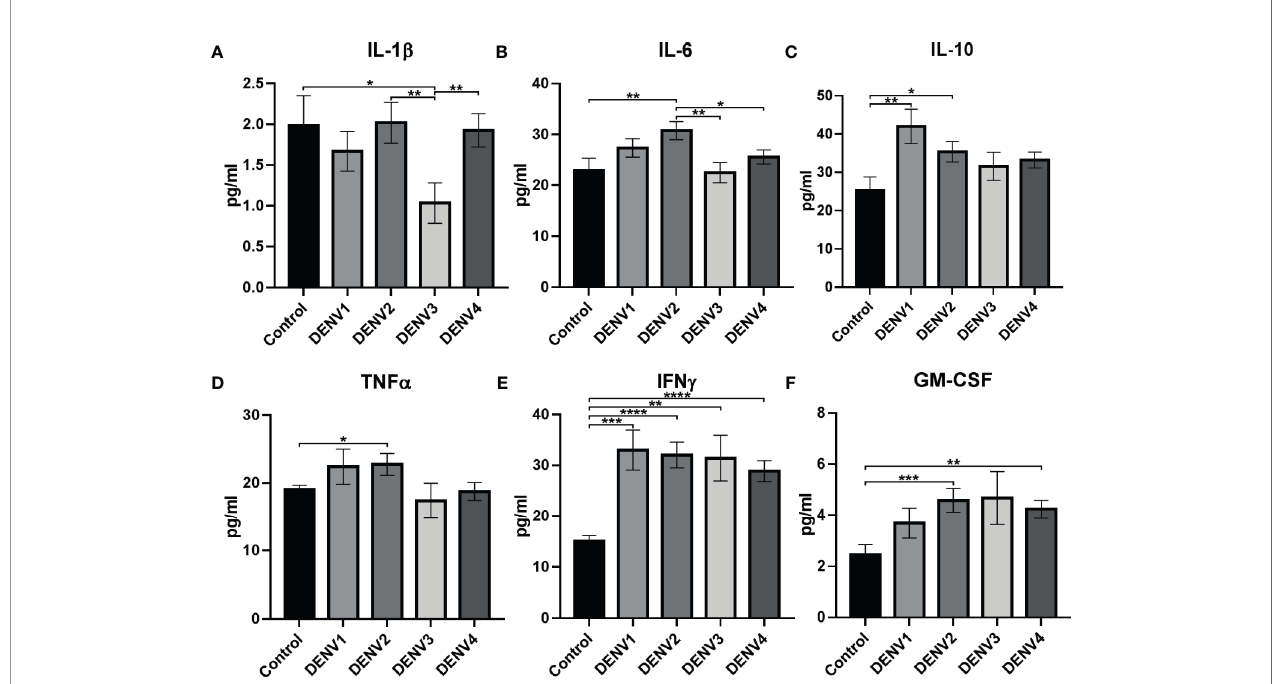
FIGURE 5 | Cytokine expression in different serotypes. The graph shows statistically signi fi cant cytokine expression in different serotypes: (A) IL-1 b , (B) IL-6, (C) IL-10, (D) TNF a , (E) IFN g , and (F) GM-CSF. The statistical analysis was calculated using Welch ’ s two-tailed t test between control and different serotypes and between different serotypes. Statistical signi fi cance was shown in asterisks: * P < 0.05, ** p < 0.01, *** p < 0.001, **** p < 0.0001. The error bars represent SEM. [Control (N=20), DENV1 (N=14), DENV2 (N=22), DENV3 (N=7), DENV4